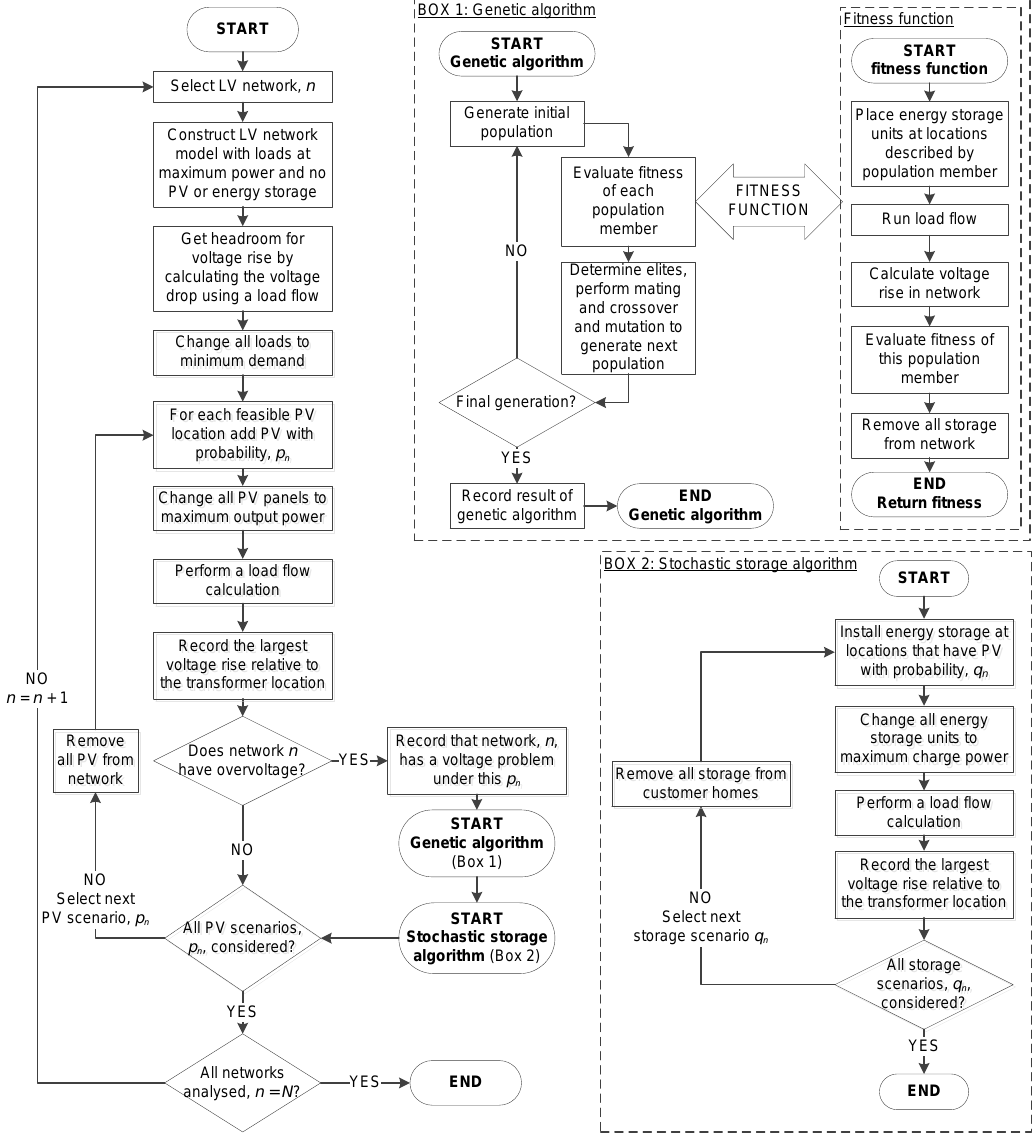
Figure 2. Proposed method for assessing the impact of multiple photovoltaic (PV) dispersion levels, p n , on the voltage regulation in multiple LV networks and the subsequent effect of energy storage randomly installed in customer homes with dispersion q n or sited by DNOs, to manage overvoltage.